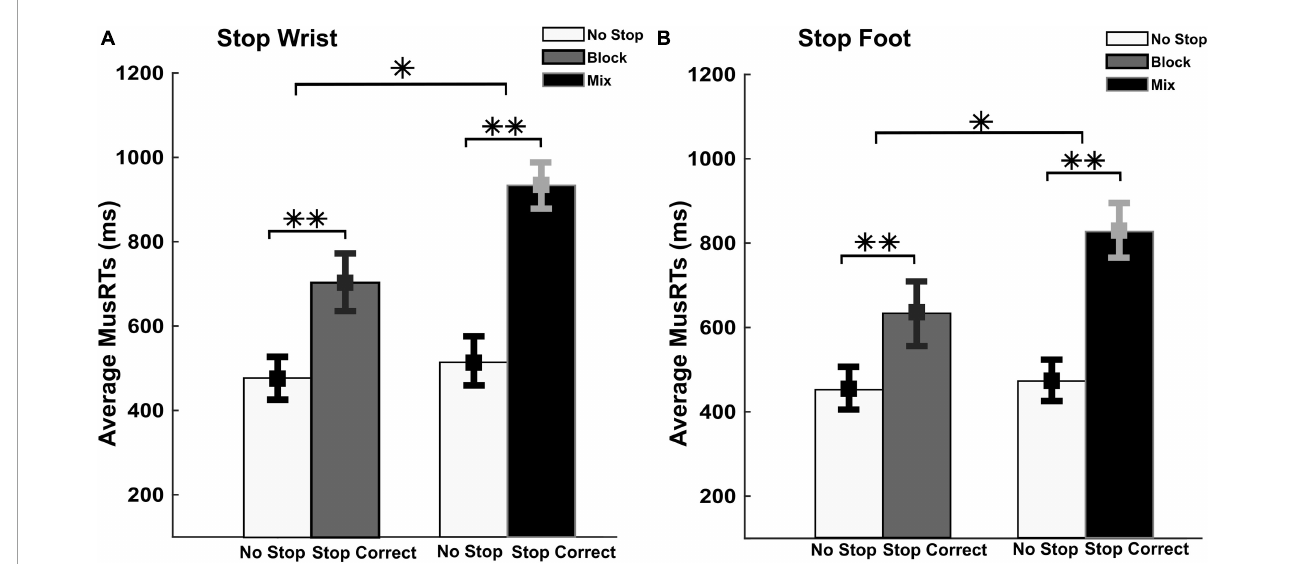
FIGURE3 Evaluation of the moving effector and the stopping interference in Stop Correct trials. No Stop and Stop Correct MusRTs in both, selective Stop Wrist (A) and foot (B) in Block and Mix task condition. ∗∗ p < 0.001 and ∗ p < 0.05.